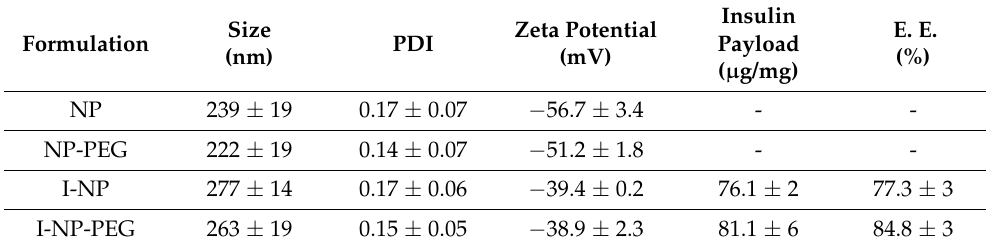
Table 1. Physico-chemical characteristics of empty (NP and NP-PEG) and insulin-loaded nanoparti- cles (I-NP and I-NP-PEG). Data expressed as mean ± S.D. ( n ≥